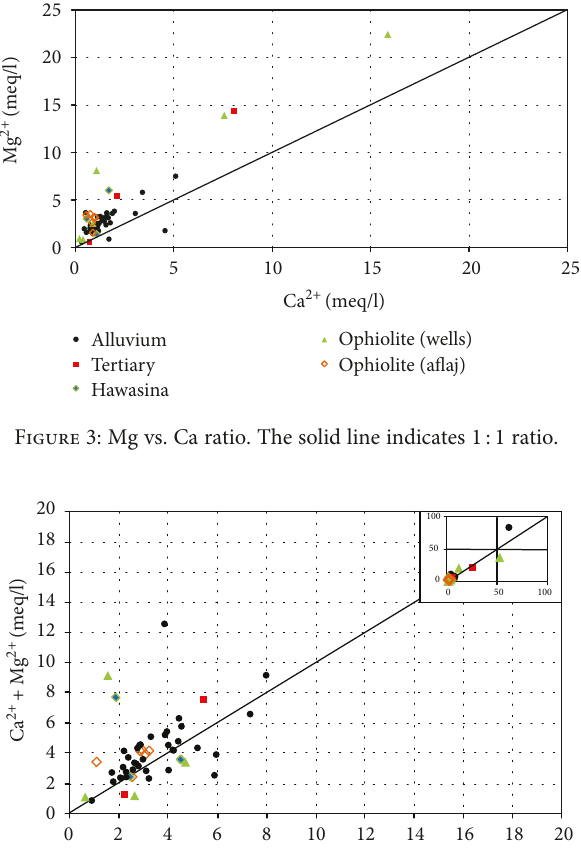
Figure 4: Variations of Ca +2 +Mg +2 vs. HCO concentrations.